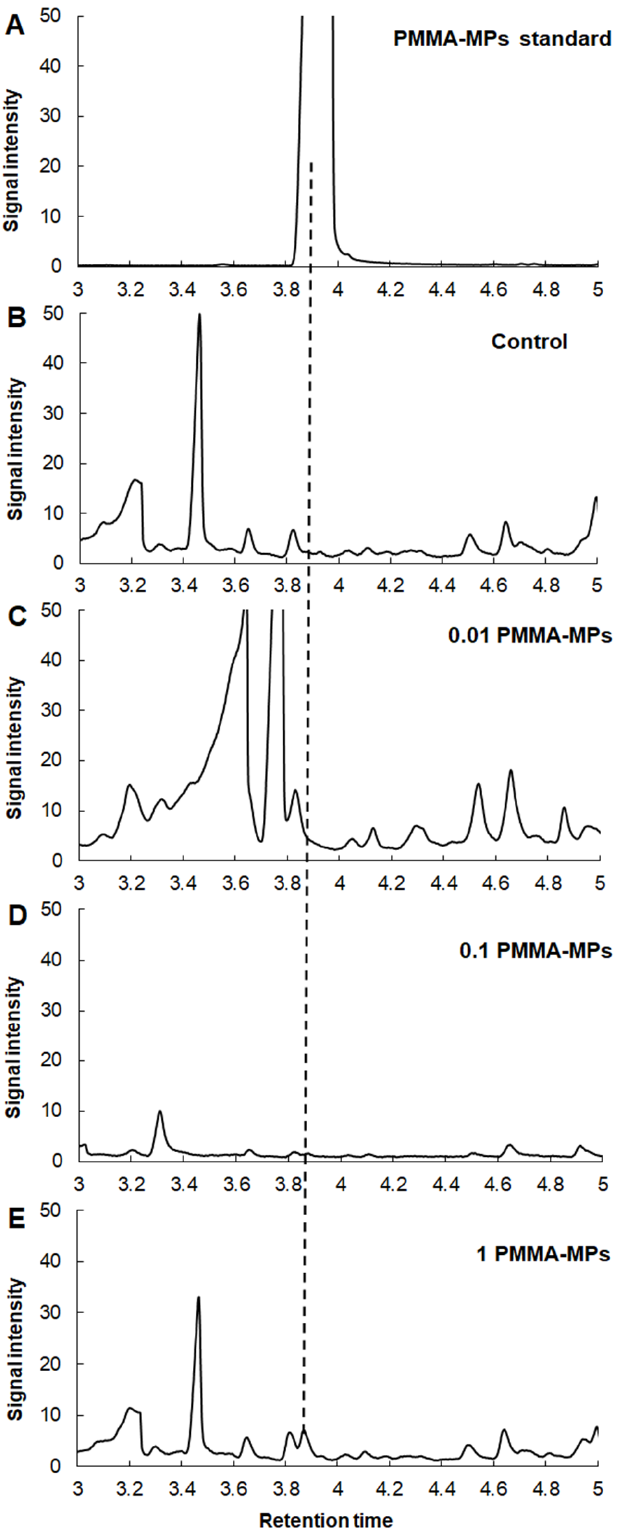
Figure 4. Extracted ion chromatogram of methyl methacrylate monomer from pyrolysis GC-MS. Standard sample of PMMA-MPs ( A ); control A. cepa roots ( B ); A. cepa roots treated with 0.01 g L − 1 PMMA-MPs ( C ), 0.1 g L − 1 PMMA-MPs ( D ), and 1 g L − 1 PMMA-MPs ( E ).